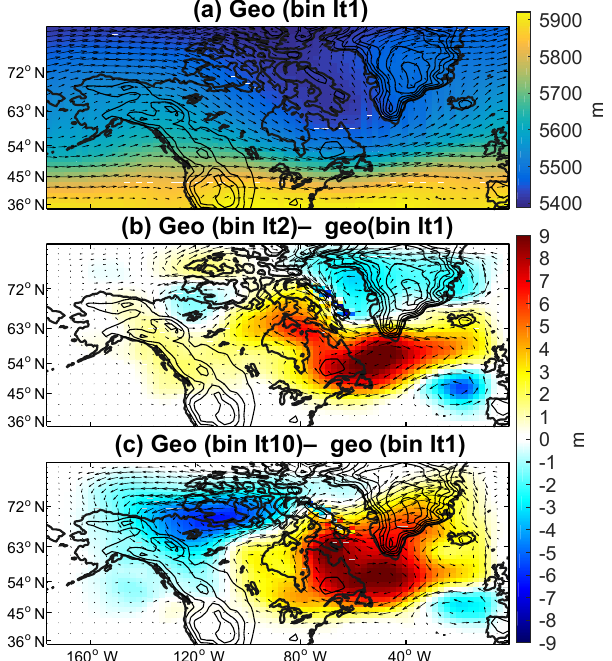
Figure 8. Changes in 500mbar geopotential height in the parent do- main in select iterations with wind vectors. Wind speeds are 6ms − 1 over Baffin Island. (a) The 500mbar geopotential height for the Iter- ation 1 simulation with average large-scale flow during the summer and (b–c) 500mbar geopotential height differences during the sum- mer between Iteration 1 and Iterations 2 and 10. Wind anomalies of 1ms − 1 are